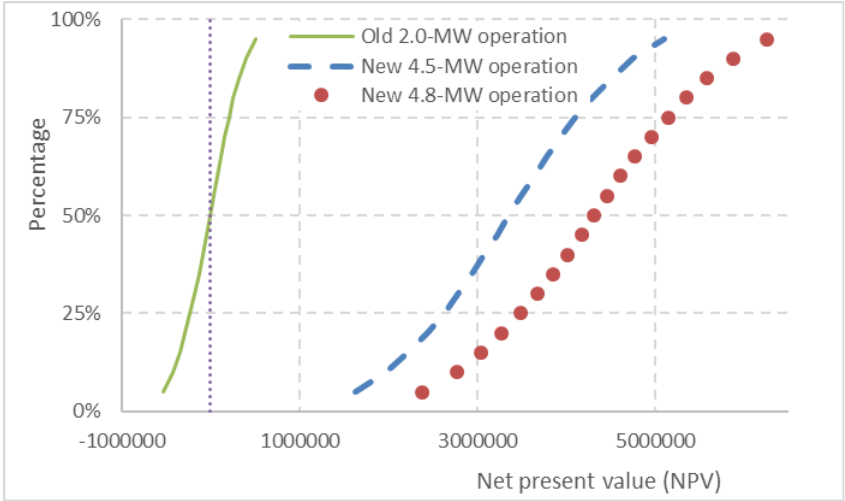
Figure 8. Distribution of the net present value (NPV) for three wind turbines with variable remuneration, operating costs, dismantling costs, and lease rate; stochastic simulation with 10,000 repetitions with @RISK; (Range 5%–95%). Source: own calculations.